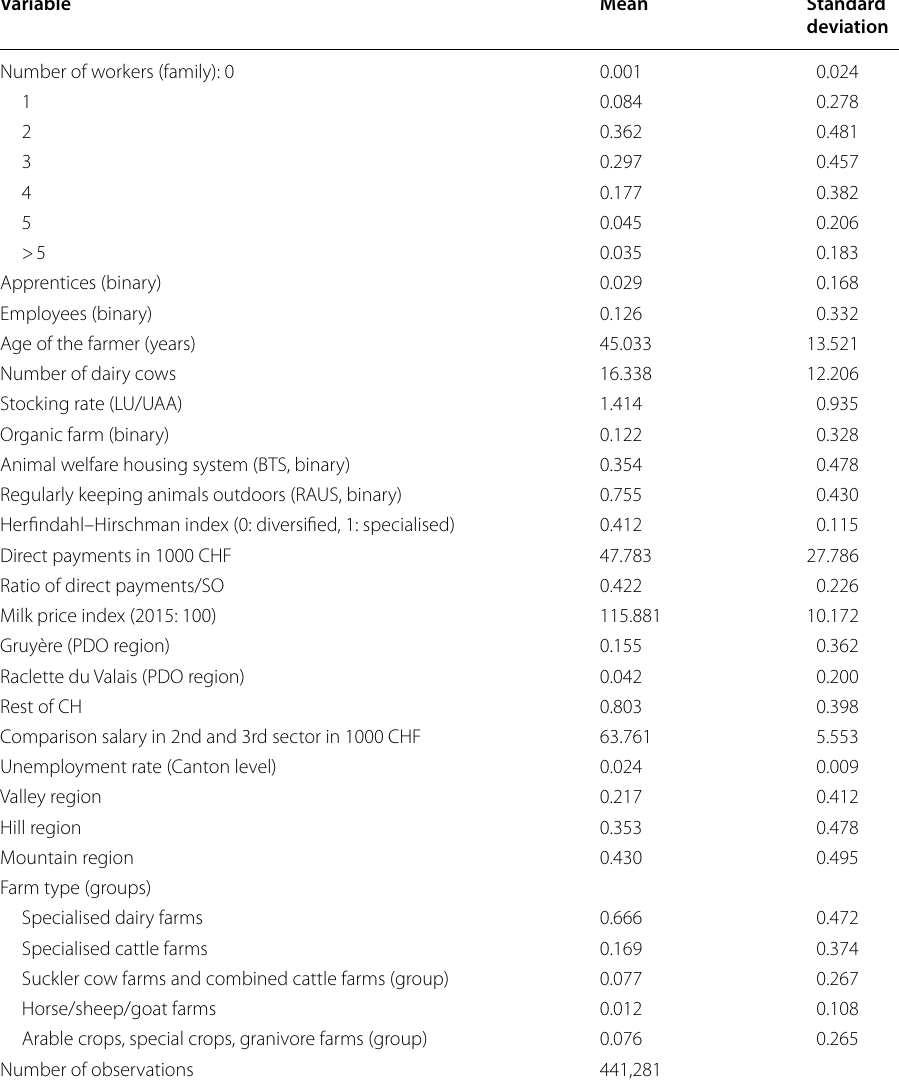
*Not displayed are the 26 Cantons (regional administrative units) and the five policy